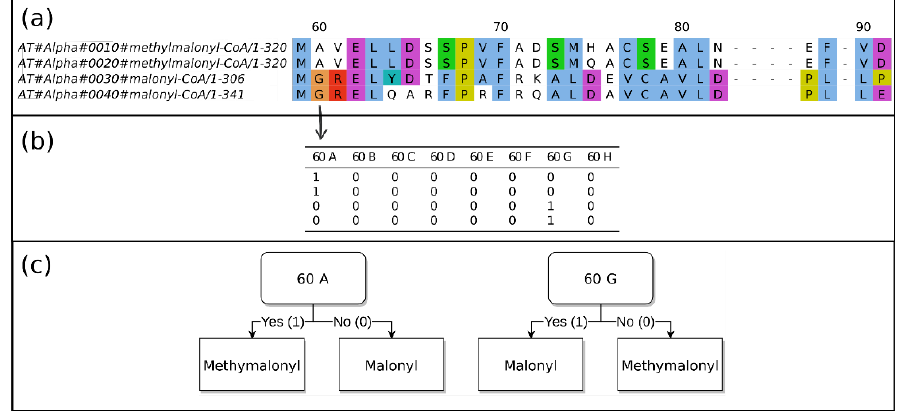
Figure 8. Explanation of the sequence encoding scheme. ( a ) The annotated sequences are aligned. ( b ) Each position in the alignment is encoded in a binary feature using one-hot encoding. ( c ) The RF models are trained on the encoded arrays. A very simplified decision is demonstrated. On the live system, many more positions are taken into consideration.